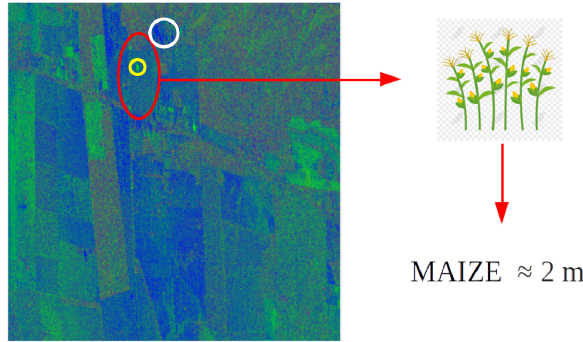
Figure 9. Pauli decomposition for the calibrated SARAT image relevant to track 19. Red: volume. Green: surface. Blue: